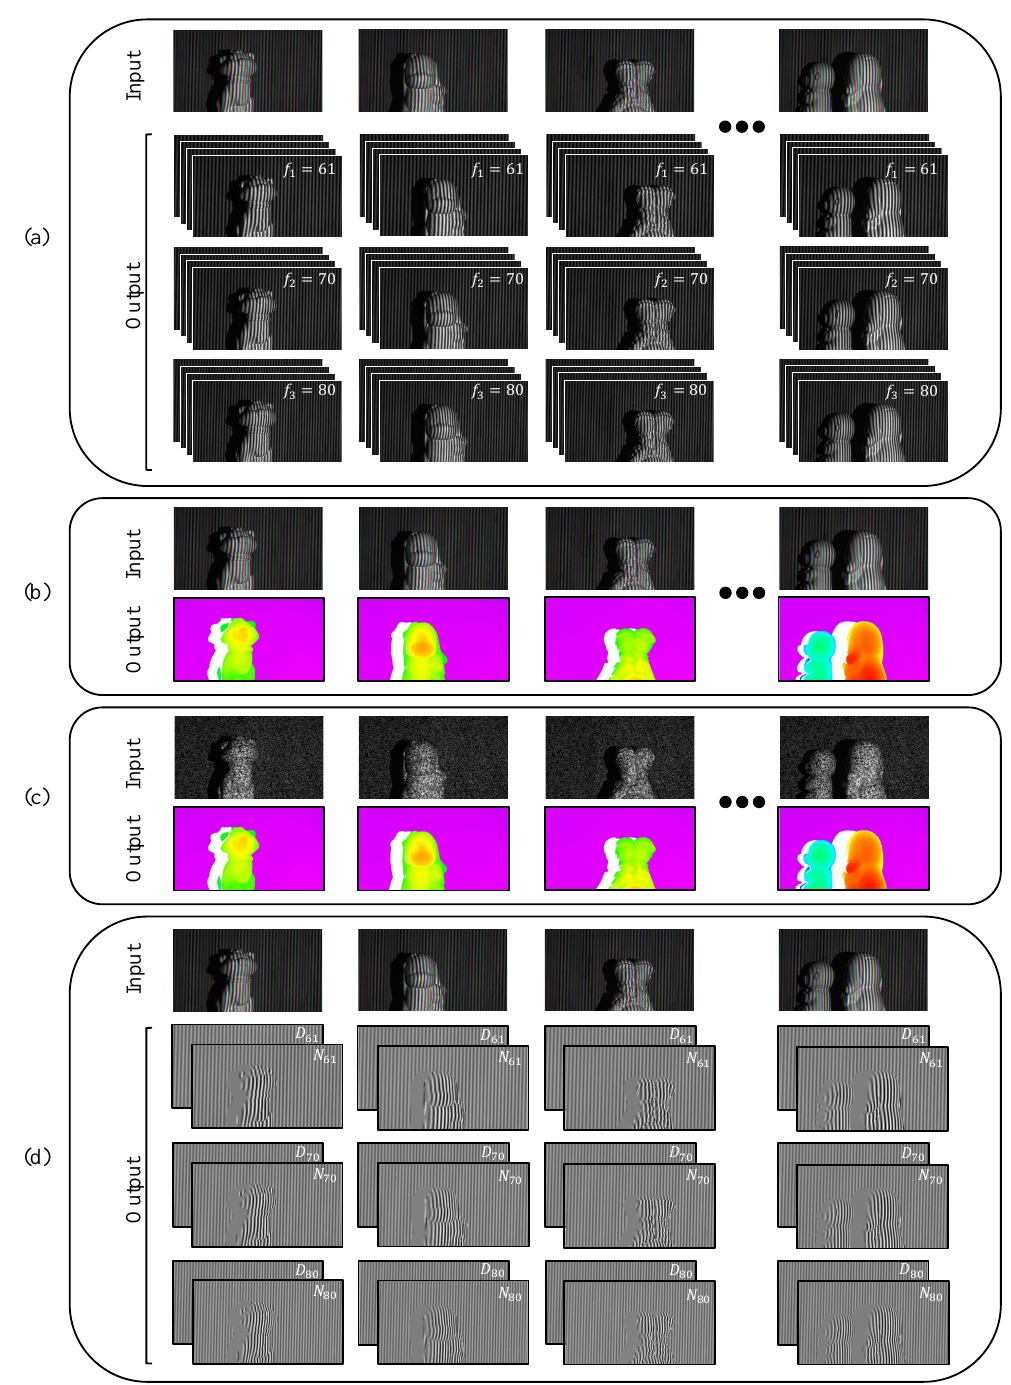
Figure 3. Examples of input and output data pairs contained in the: ( a ) fringe-to-fringe datasets; ( b ) fringe-to-depth datasets; ( c ) speckle-to-depth datasets; ( d ) fringe-to-ND